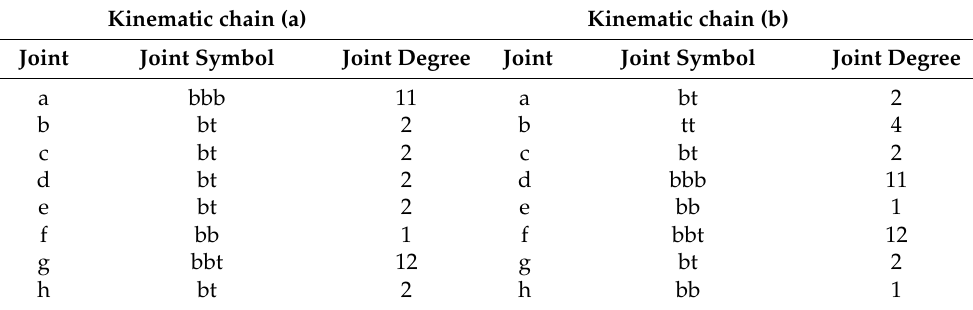
Table 6. Values of Joint degrees for kinematic chains in Figure